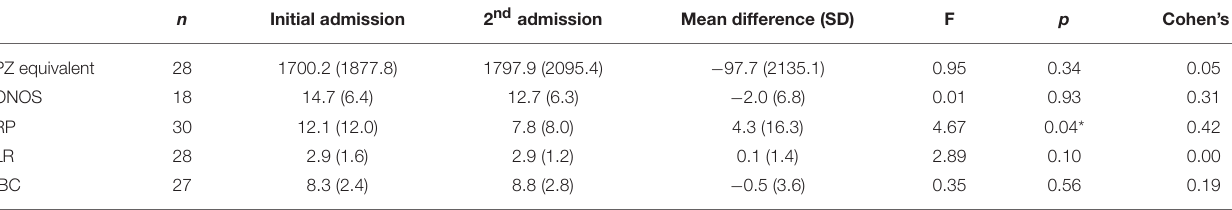
TABLE 5 | Difference in inflammatory markers at initial and repeat admission with acute